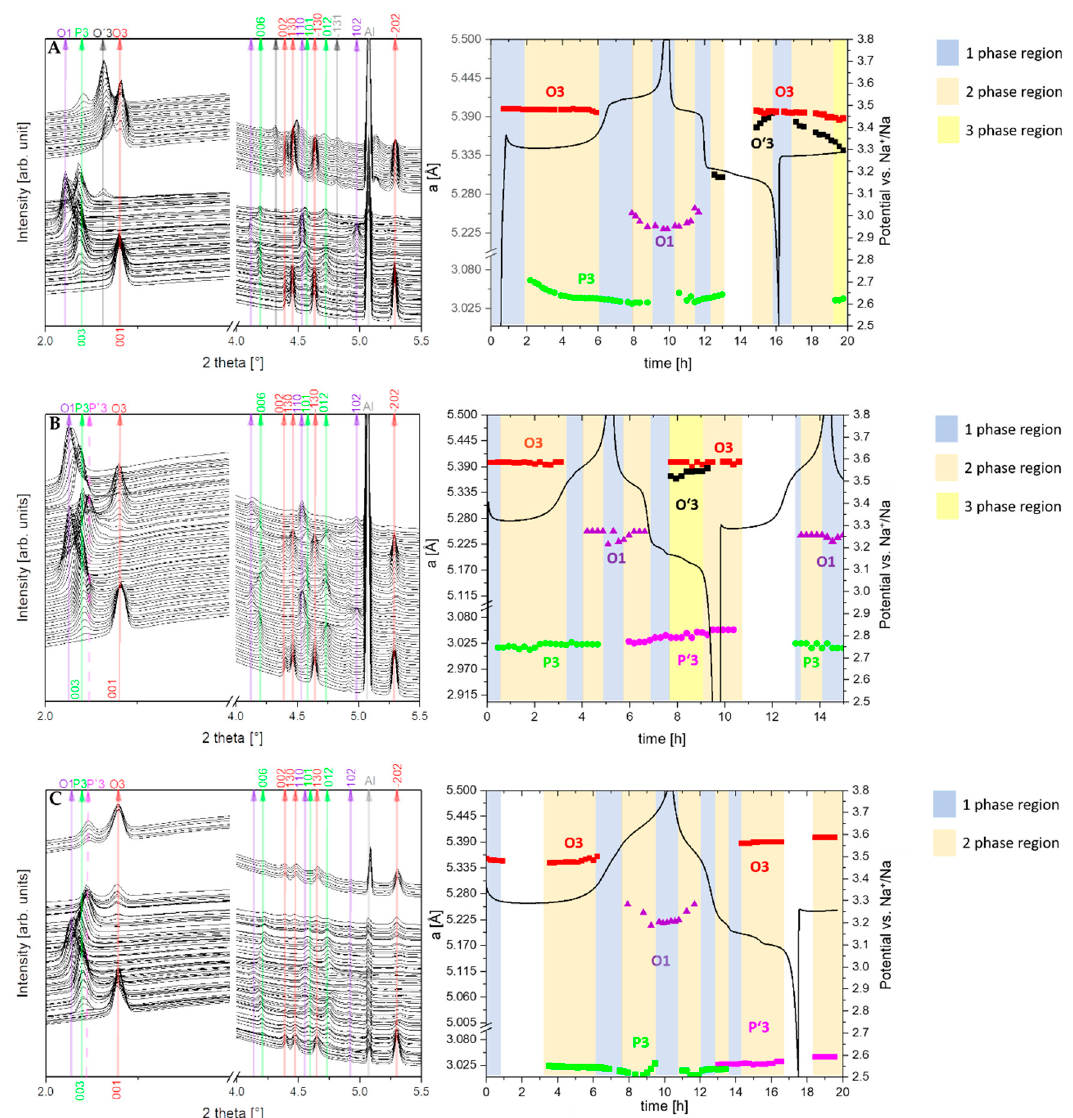
Figure 7. In operando synchrotron radiation di ff raction patterns, collected during the first charge / discharge of NNB ( A ), NNBT0.1 ( B ) and NNBT0.3 ( C ) cells under a current rate of 0.1 C at a potential range between 2.5 V and 3.8 V vs Na + / Na. The white coloured parts represent beam-lost, where di ff raction patterns are not recorded.